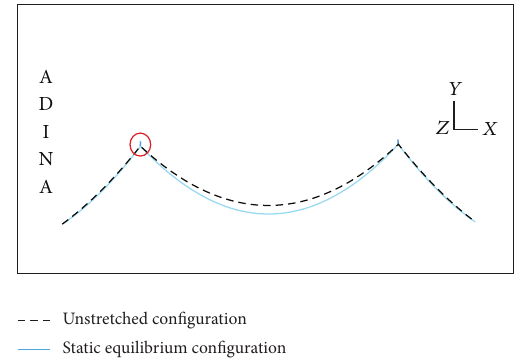
Figure 3: The unstretched and the static equilibrium configurations of the three-span cable.